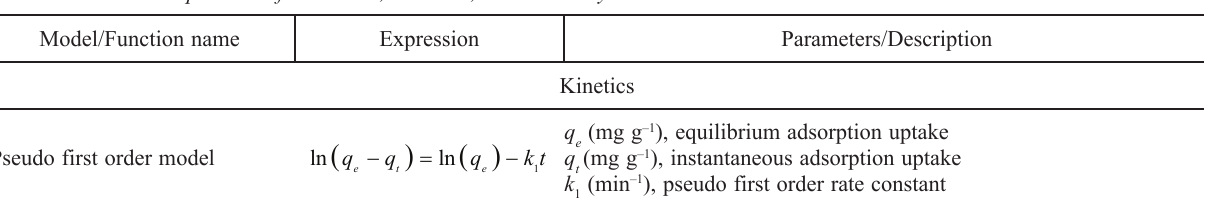
Table 1 – Model expressions for kinetics, isotherm, and thermodynamics studies Model/Function